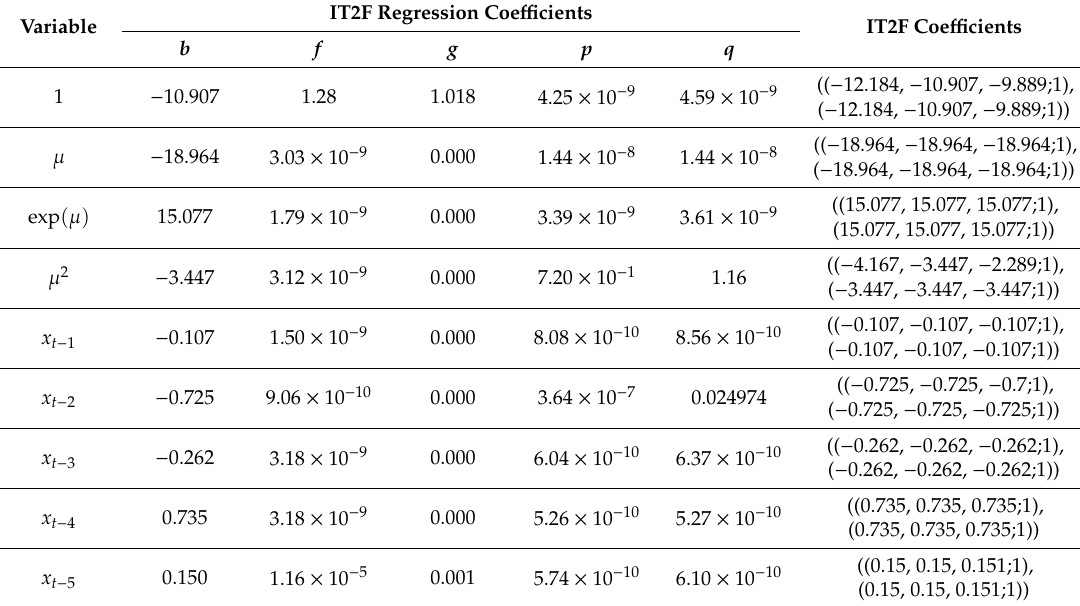
Table 5. Cluster-2 results for the 1st alternative and 1st